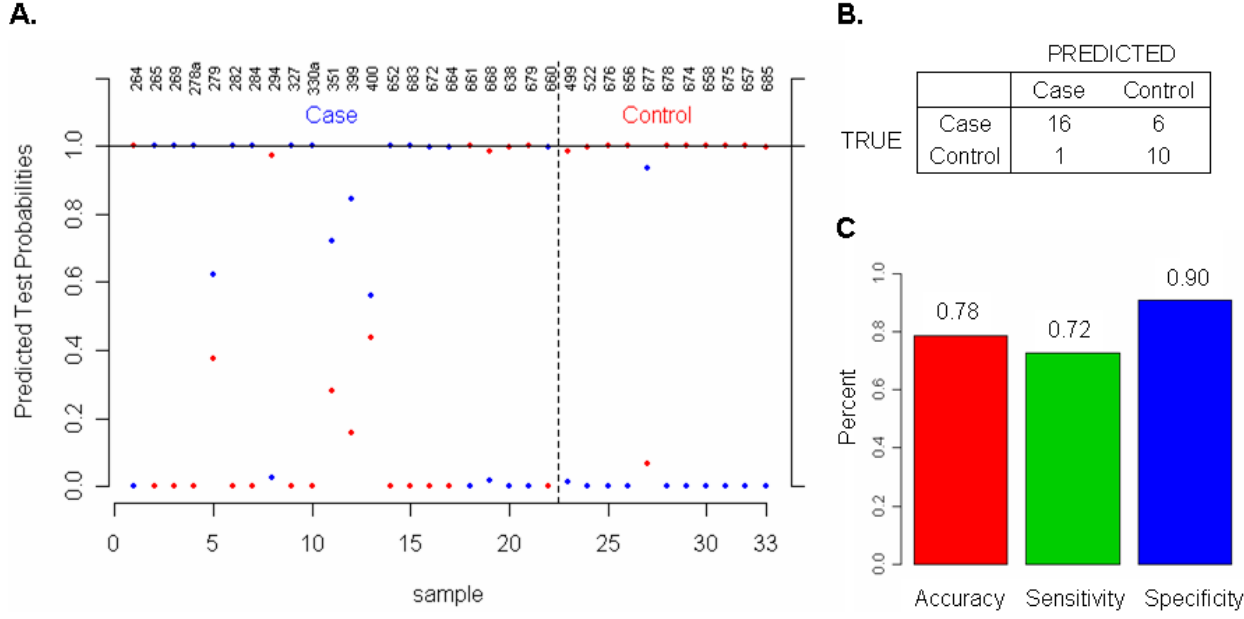
Figure 3. Validation of the 41-gene classification model using microarray analysis on an independent set of testing samples. (A). Classification probabilities for each testing sample: TAA (case) vs. normal (control); (B). Contingency table summarizes the predicted and actual class membership for the testing set; (C). Classification accuracy, sensitivity and specificity.